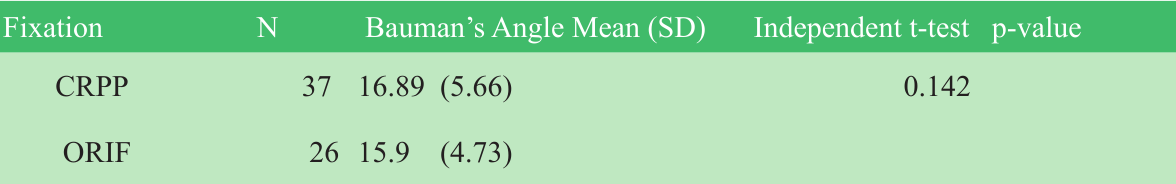
Table 5: Bauman’s Angle and Type of Fixation